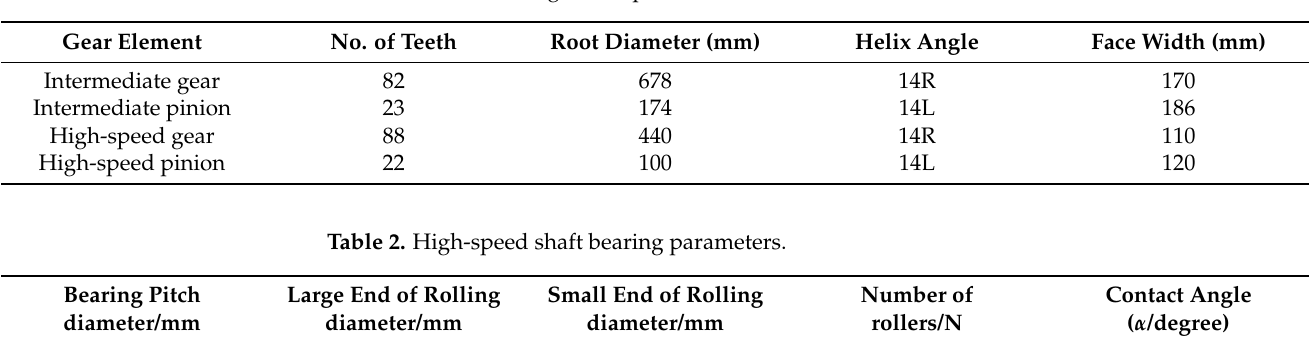
Table 1. Parallel shaft gearbox parameters.